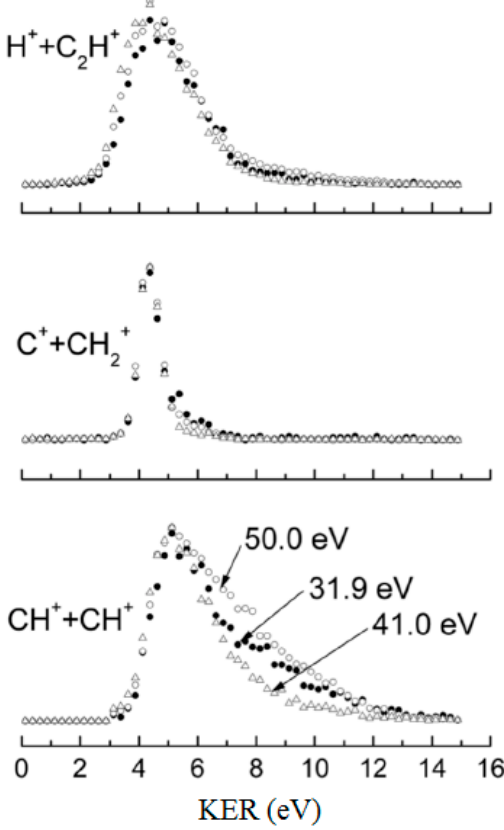
Figure 3. Total kinetic energy distributions of ion products for the three dissociation channels (see reactions 1–3 in the text) at some representative photon